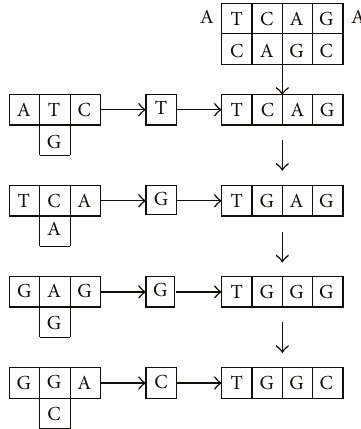
Figure 2: Encryption processes by RT-DNA CA.